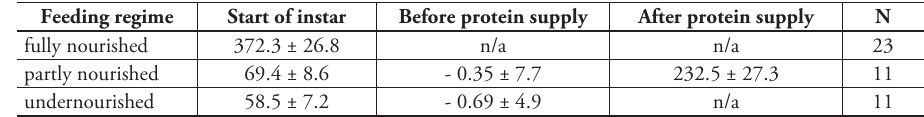
Table 4. Growth rates (in mg/day) of the differentially fed larvae at the start of the final instar/ before and after protein addition to the starved larvae. The values are given as mean ±